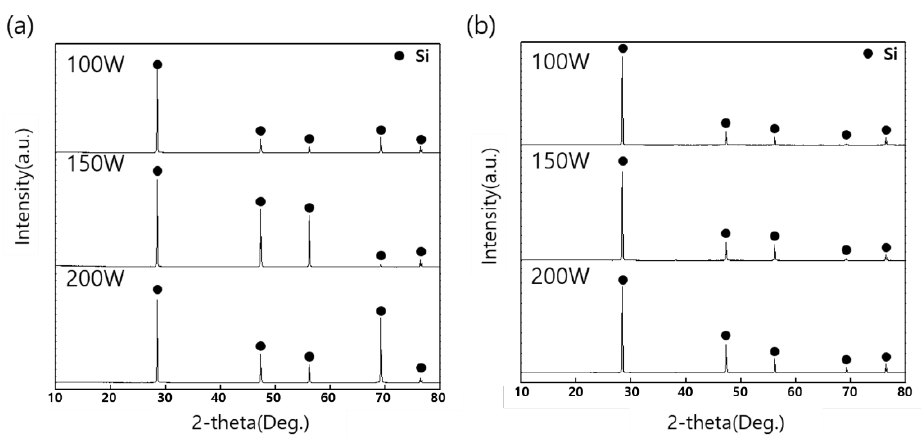
Figure 9. XRD analysis results of a photovoltaic cell after drying—ultrasonic intensity. ( a ) HNO 3 and ( b ) HCl. Table 10. XRF analysis results of a photovoltaic cell after drying—ultrasonic intensity (unit: wt.%).